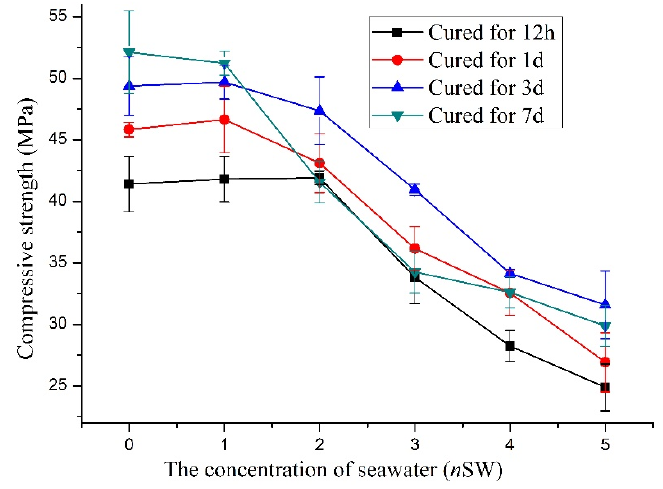
Figure 6. Influence of seawater concentration on the compressive strength of CSA cement.